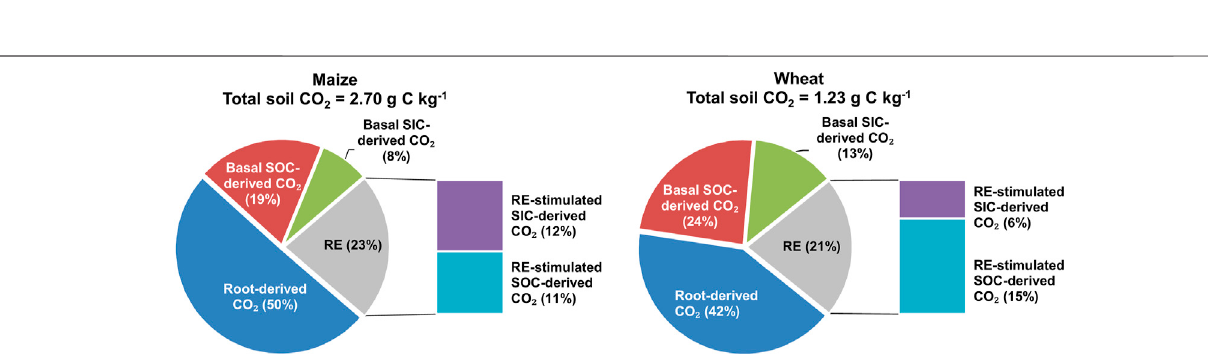
Frontiers in Environmental Science |